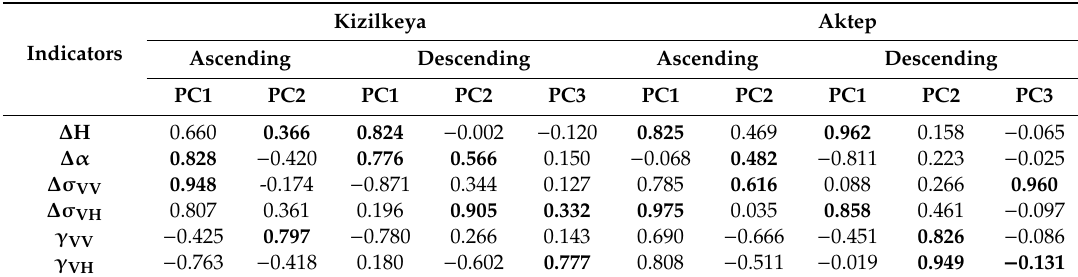
Table 6. Rotated factor loadings of Principal components